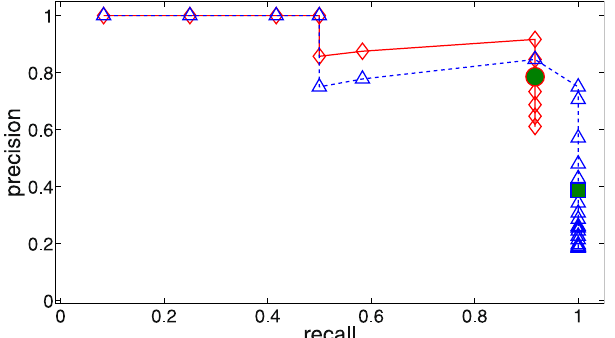
Figure 5. A single typical realization of a precision/recall curve for only thresholding the mutual information (blue triangles and dashed line) and the maximum entropy method being applied to thresholded mutual informations (red diamonds and solid line), similar to Fig. 3. The blue square filled green shows the performance of applying local thresholds to the mutual informations and the red circle filled green the performance of additionally applying our maximum entropy method. The thresholds are determined by the surrogate method discussed in the main text using the p = 98.5 percentile. 700 surrogates were generated.